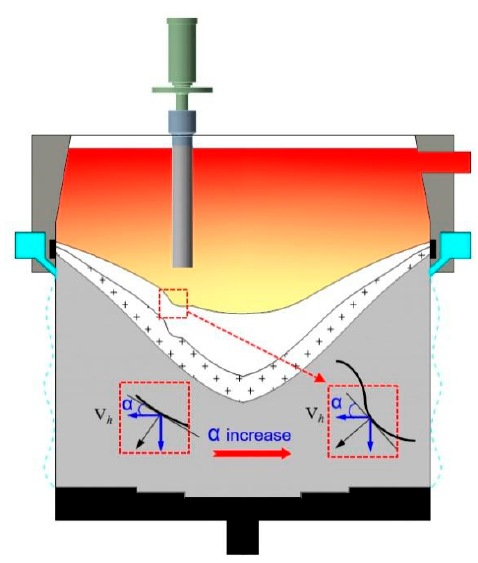
Figure 9. Effect of ultrasonic changes on the solidification front. Figure 9. E ff ect of ultrasonic changes on the solidification front.